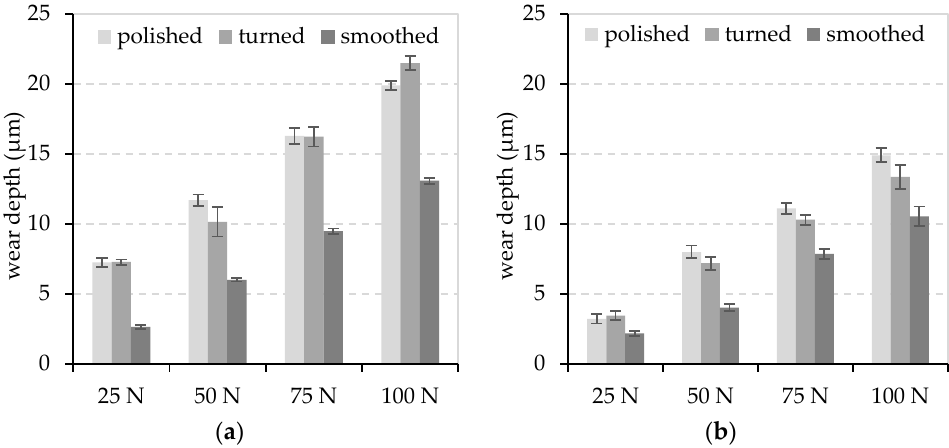
Figure 5. Scratch wear depth of X120Mn12 ( a ) SPS ( b ) HVOF specimen in relation to surface condition and the indention force.